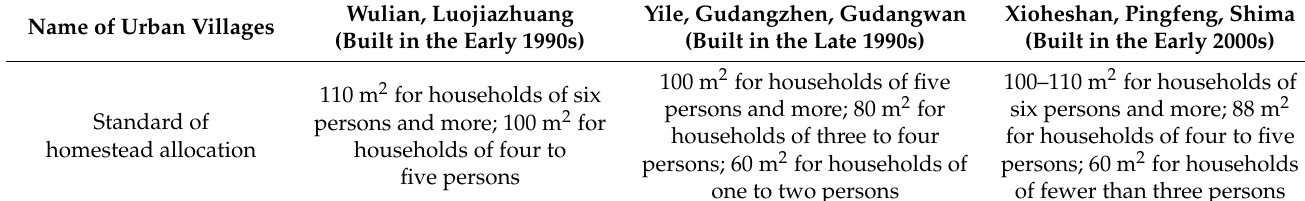
Table 4. Standard of homestead allocation for urban villages of the first category.